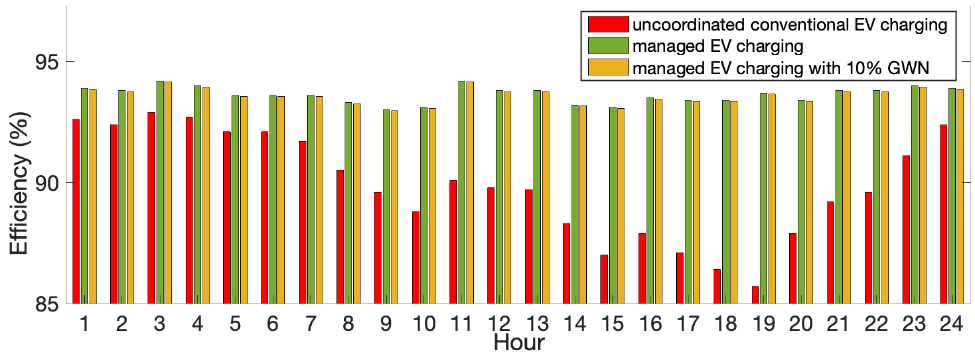
Figure 10. Comparison of distribution system efficiency of different situations with 10%